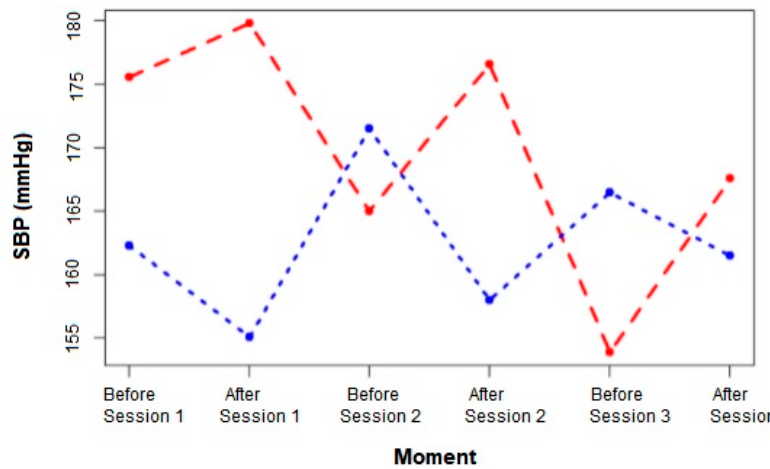
Figure 3. Mean values for SBP in dogs IRIS CKD Stage 4 undergoing CT (red line) and IHD (blue line) after three treatment sessions. Table 5. Mean and standard deviation of the predictive parameters of arrhythmias and HRV indexes of the control group and of dogs with IRIS CKD Stage 4 after the third session of CT and